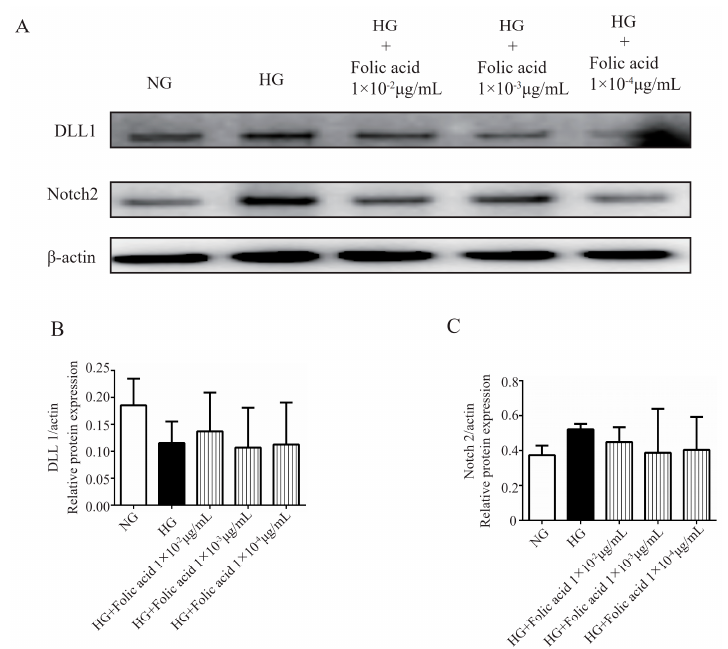
Figure 6. Folic acid promoted the protein expression of DLL1 and attenuated the protein expression of Notch2 in the RVECs. The cells were incubated with 1 × 10 − 2 µ g/mL, 1 × 10 − 3 µ g/mL, 1 × 10 − 4 µ g/mL of folic acid for 72 h. The protein expression levels of DLL1 ( A , B ) and Notch2 ( A , C ) were assessed by western blot. The data was presented as means ± SD ( n = 3).